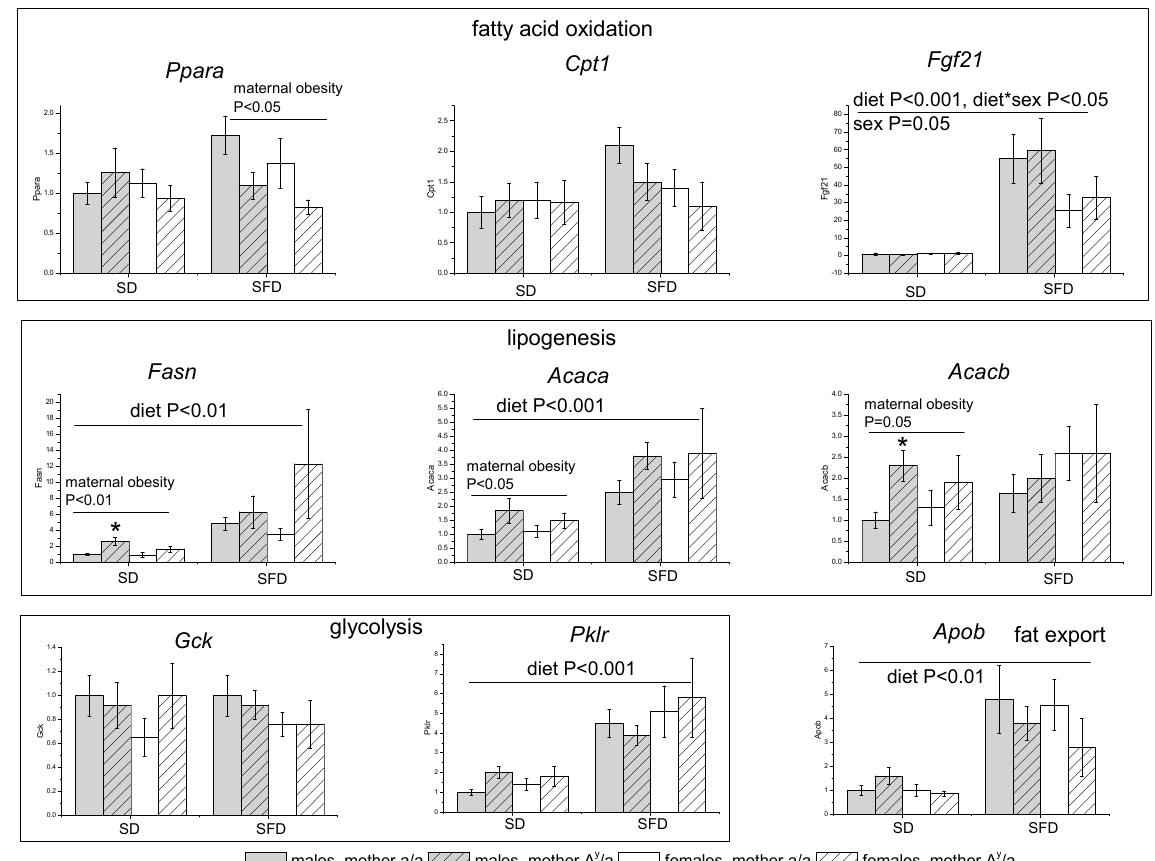
Figure 5. Liver gene expression in male and female offspring of control and obese mothers under consumption of SD or SFD. Male and female offspring of obese ( A y /a ) and control ( a/a ) mothers were fed with SD or SFD for 10 weeks from the age of 10 weeks. Data are presented as mean ± SE for 5–7 mice in each group. Y axis designates fold changes in gene expression as compared to group of SD males born to control ( a/a ) mothers. Data were analyzed by three-way ANOVA with factors “sex”, “diet”, and “MG” and separately for SD and SFD by two-way ANOVA with factors “sex” and “MG”. * p < 0.05, post hoc Newman–Keuls test between male offspring of a/a and A y /a mothers. In the hypothalamus, SFD consumption increased gene expression of anorexigenic factors ( Crh and Pomc ) and decreased gene expression of orexigenic factor Npy in mice of both sexes and had no effect on the expression of the genes for the leptin receptor and for MC4R (Figure 6). Gene expression of orexigenic factors ( Npy and Agrp ) in females was lower than in males. Maternal obesity did not affect the expression of the studied genes in the